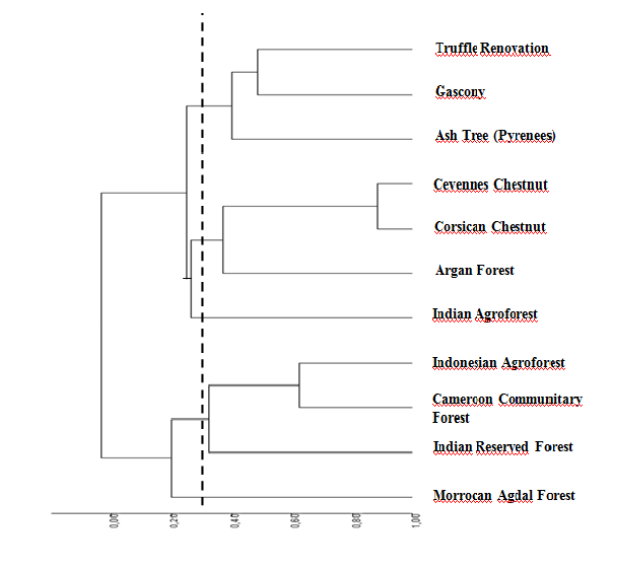
Fig. 2 . Cluster Analysis of the 11 case studies of rural